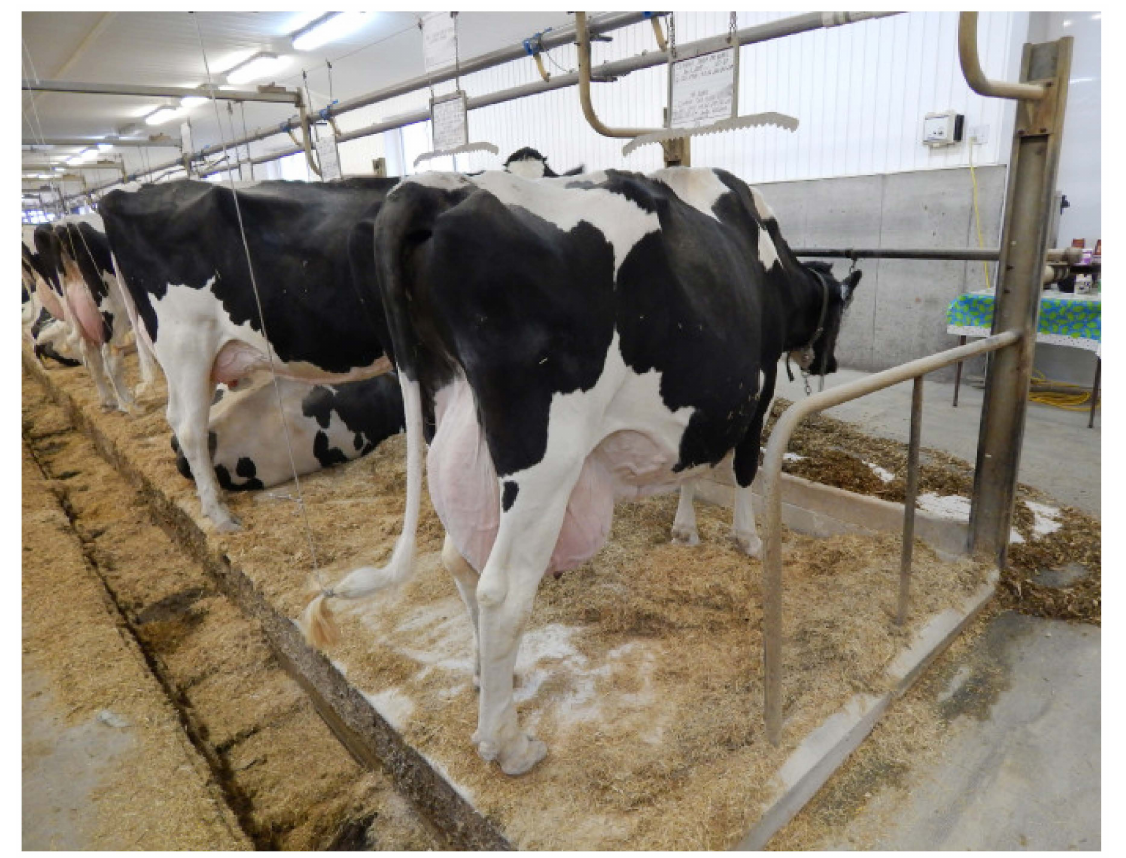
Figure 4. Tie-stall barn with shallow litter (A.